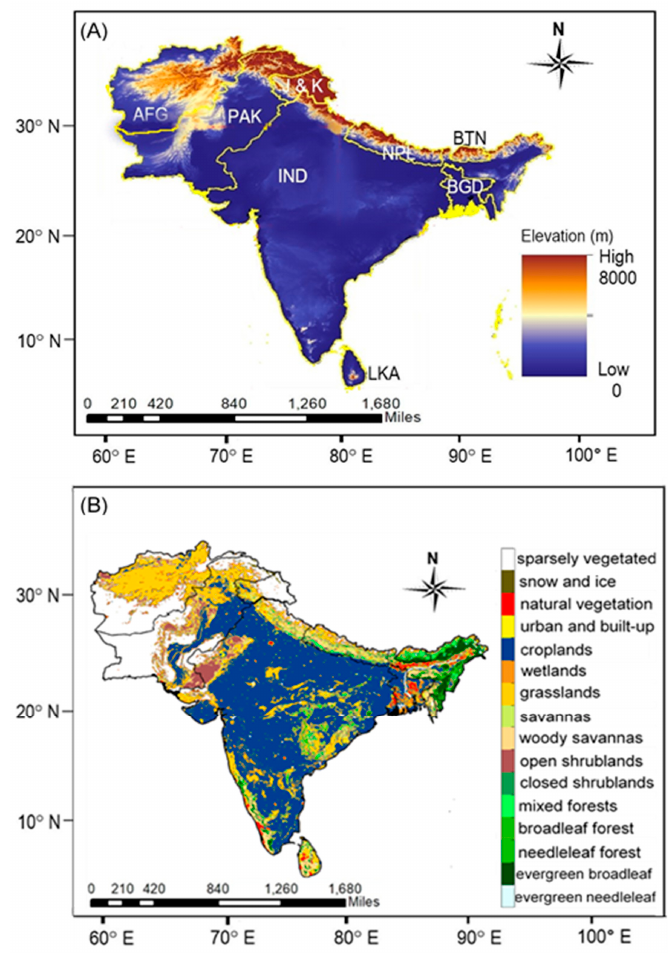
Figure 1. ( A ) Elevation map of South Asia. ( B ) Land cover types in the study area as generated with the MODIS MCD12 dataset.